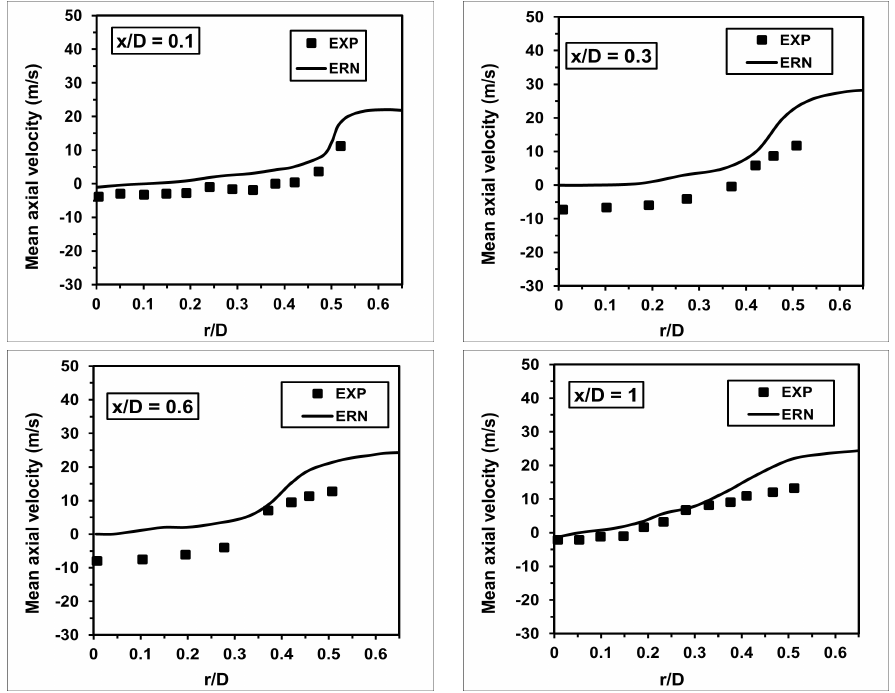
Figure 6. The computed mean velocity is compared to the experimental measurements at axial locations x / D : 0.1, 0.3, 0.6, and